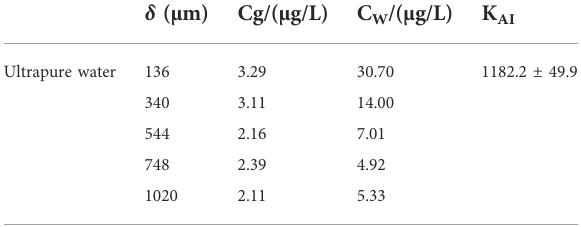
TABLE 1 Interface air-water partition constants of CN for ultrapure water.